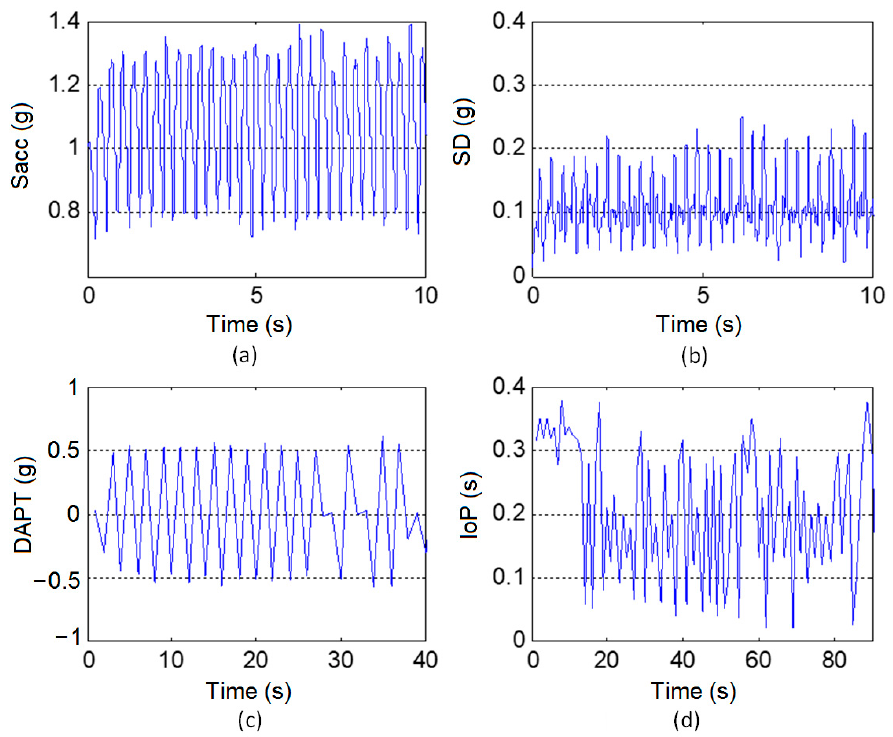
Figure 9. Diagram of features in D04: ( a ) Sacc over time; ( b ) SD over time; ( c ) DAPT over time; ( d ) IoP over time.